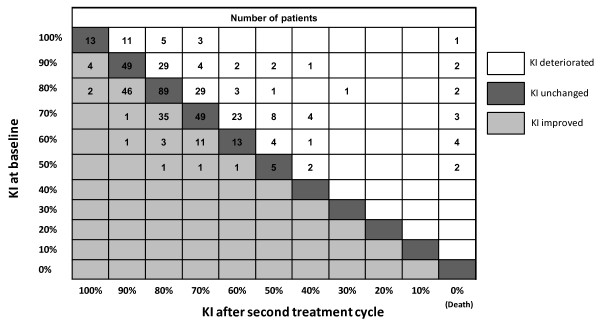
Shift table presenting the number of patients by baseline KI and KI after second treatment cycle with pemetrexed. KI = Karnofsky Index